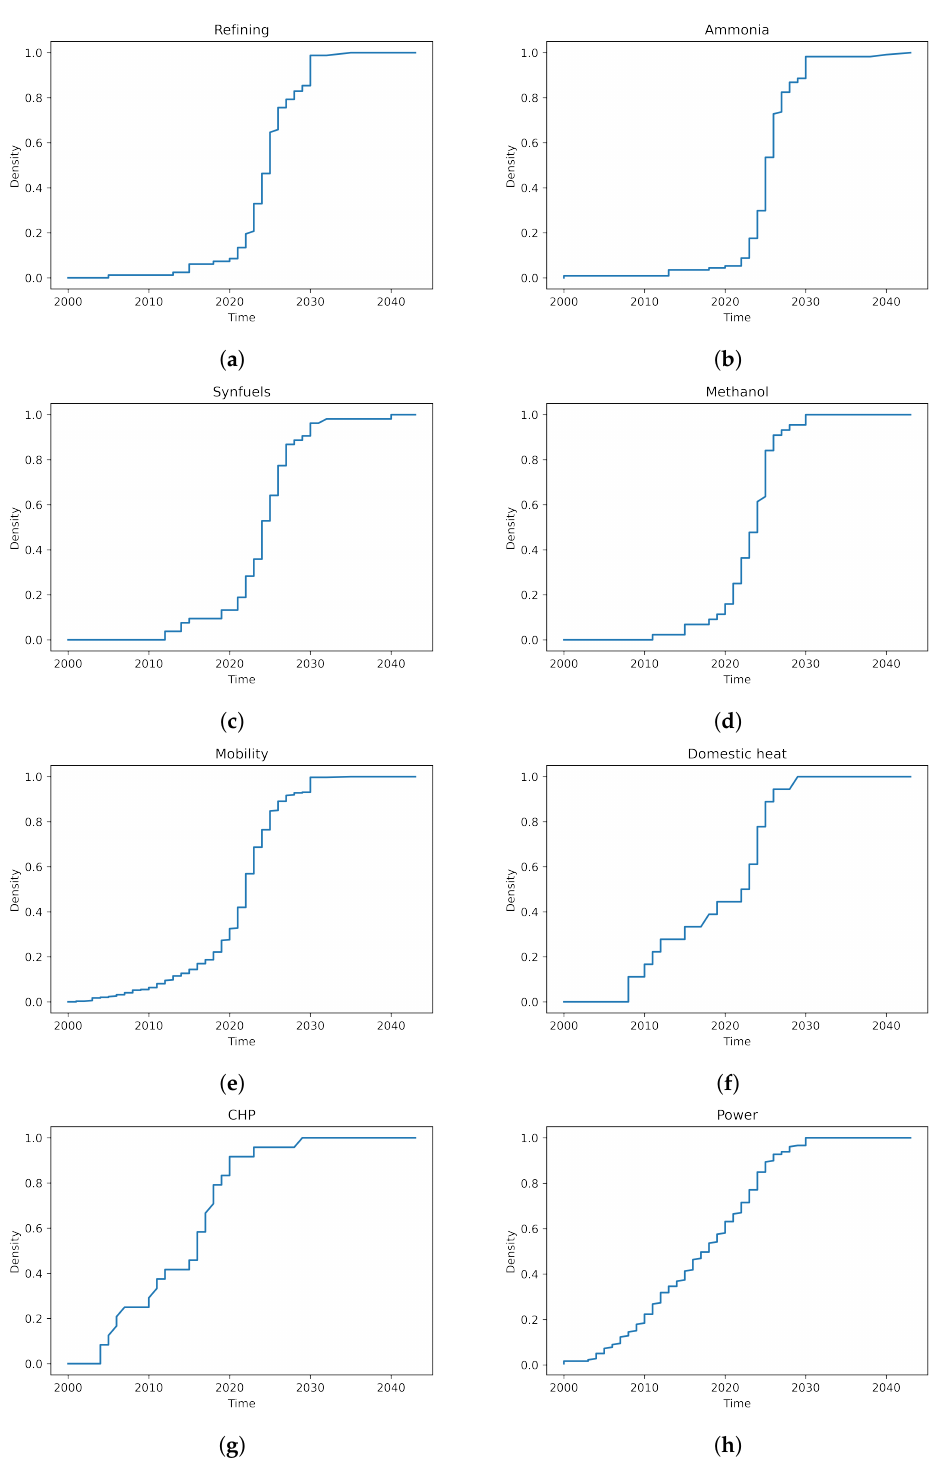
Figure 1. Cumulative distribution functions F S for eight sectors S , ( a ) refining ( b ) ammonia ( c ) synfuels ( d ) methanol ( e ) mobility ( f ) domestic heat ( g ) CHP ( h ) power. Sectors are described in Section 2. The greatest collective similarity is observed between industrial applications, with an explosion of planned plants in the 2020’s. Power serves as an anomaly with its highly uniform trend of new